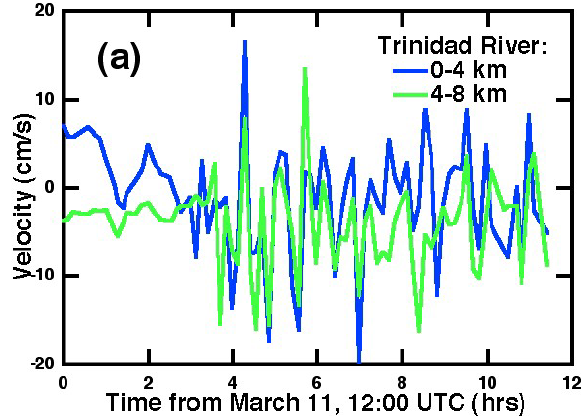
Figure 8. Time-series of radial velocities measured by the long-range radar at Trinidad River and simultaneous water level observations from the Crescent City tide gauge. Radial velocities were resolved perpendicular to the shore, and averaged over bands 4-km wide parallel to the